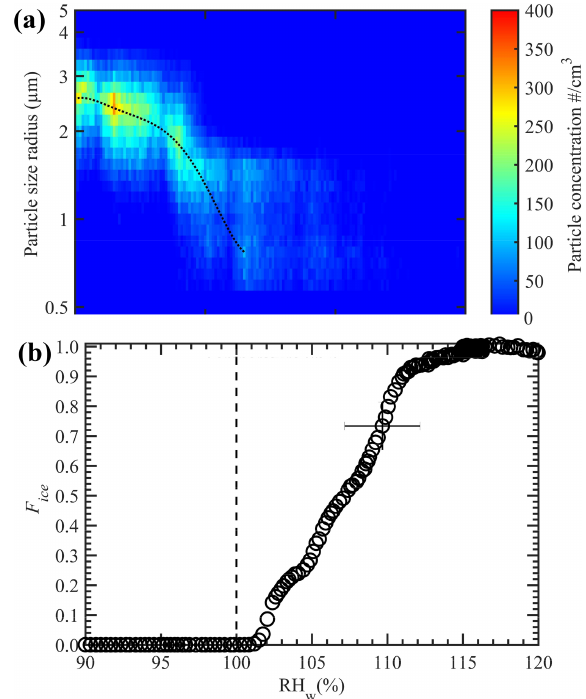
Figure 5. Homogenous freezing of water droplets containing 1wt% ammonium sulfate solution. (a) OPC-classified ice particle concen- trations as a function of ice crystal diameter at different tempera- tures. Warm and cold walls of conditioning section are maintained at − 9 and − 27 ◦ C, respectively. (b) The fraction of frozen solution droplets with RH w , where the temperature of the nucleation section is maintained constant at − 42 ◦ C to induce droplet freezing via the homogeneous freezing mode, and RH w within the conditioning sec- tion was steadily increased from 90% to 120%. Slightly colder tem- perature ( − 42 ◦ C) than homogeneous freezing limit ( ≈− 38.5 ◦ C; panel a ) is used to account for the uncertainty within temperature and RH w conditions. The dashed line in panels (a) and (b) indicate the increase in freezing fraction of droplets trend (for illustration purposes) and the onset of saturation line, respectively. The uncer- tainty in RH w is shown as an error bar (see the text for more details). The uncertainty in F ice is 1 standard deviation ( n = 3). For clarity, error bars are shown only for one data